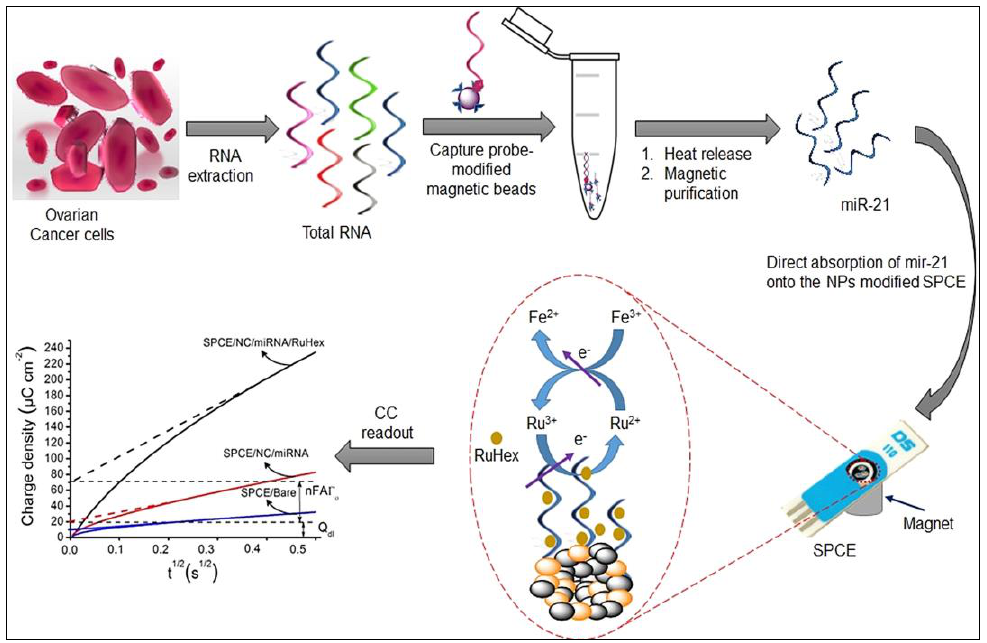
Figure 4. MicroRNAs (MiRNA) quantification assay on GO / IO- modified screen-printed carbon electrode (SPCE), based on intercalation of [Ru(NH3) 6 ] 3 + within the target miRNA and chronocoulometric detection while using [Ru(NH3) 6 ] 3 + -Fe(CN) 6 ] 3 − couple. Reproduced with permission from [77].